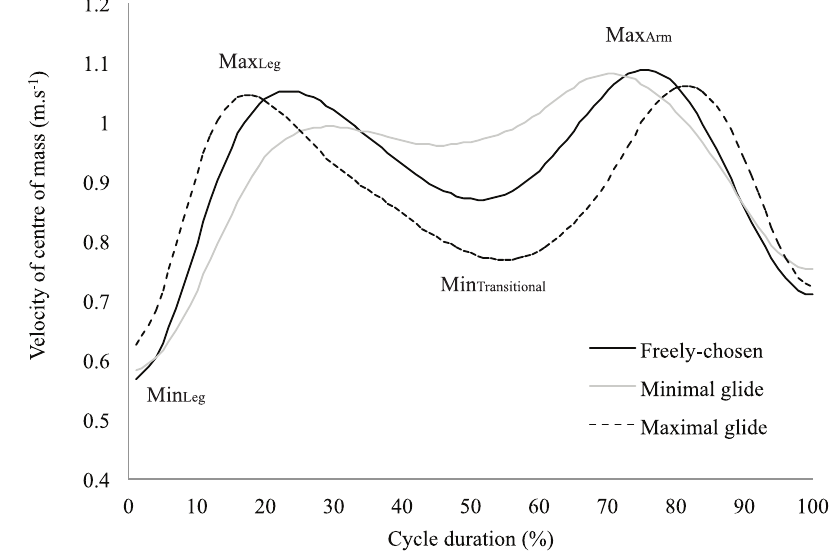
Figure 4. Instantaneous velocity of the center of mass (mean of six cycles) for the three coordination conditions.